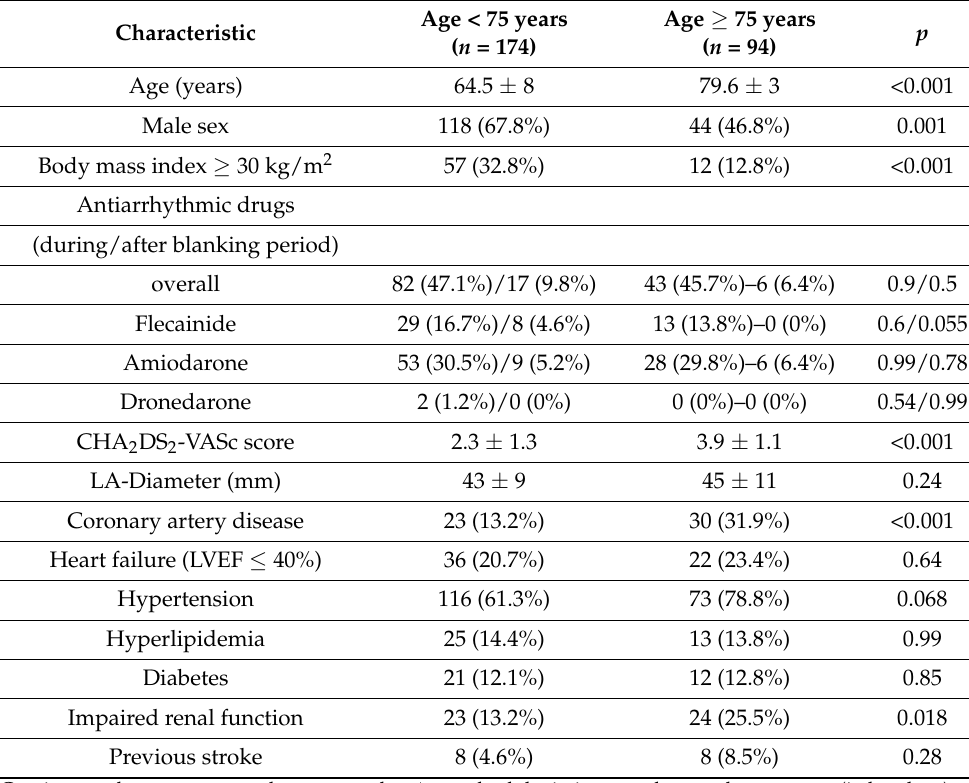
Table 1. Baseline characteristics according to